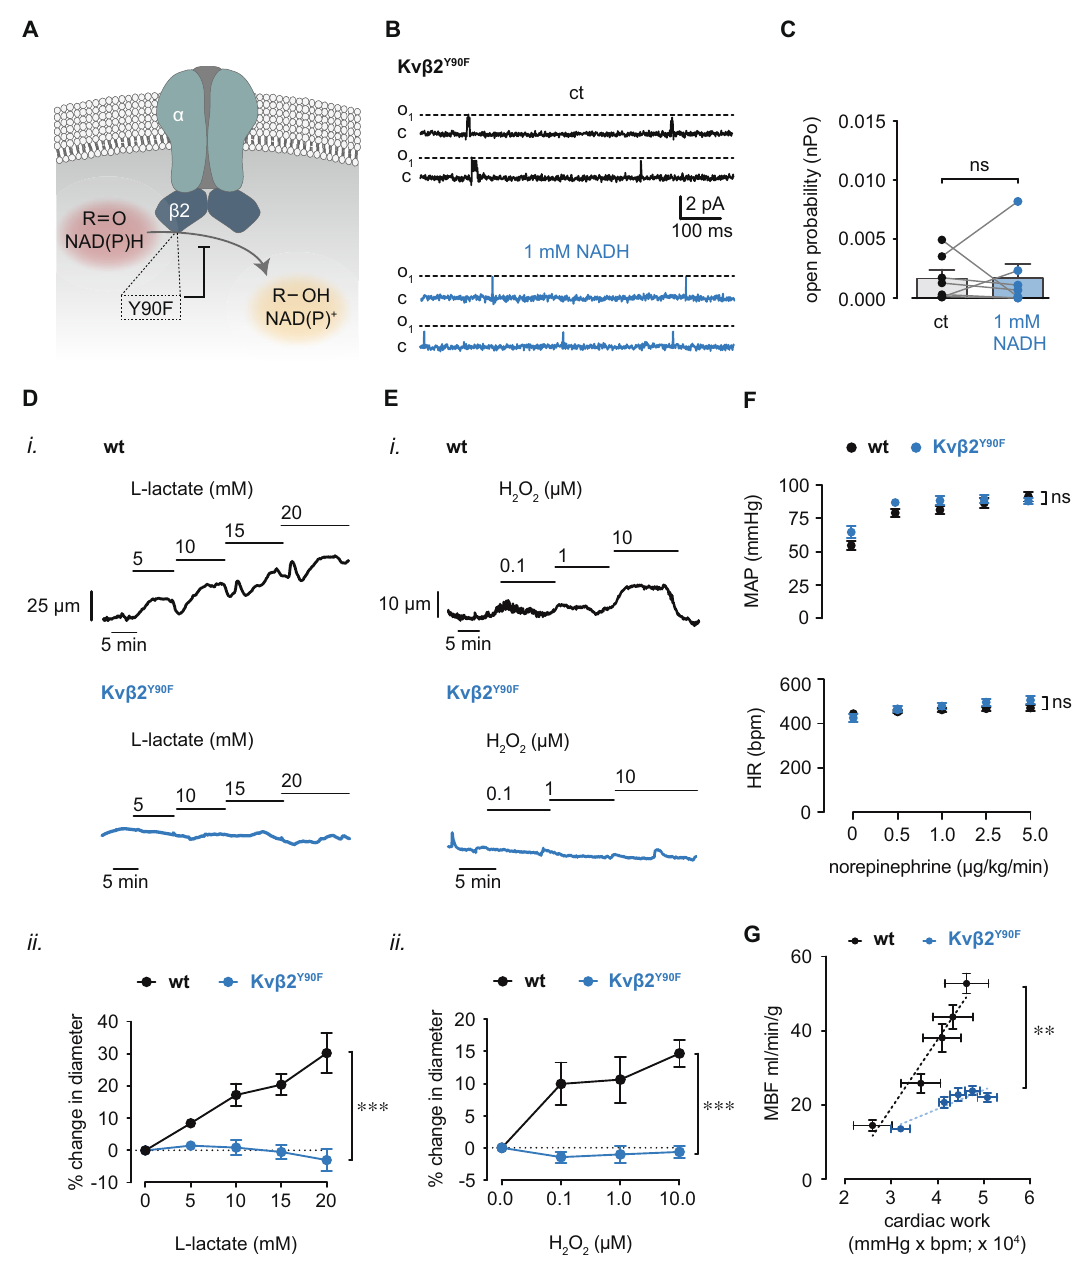
Fig. 5 Loss of Kv β 2 catalytic function prevents redox-mediated increases in Kv1 activity and vasodilation, and suppresses MBF. A Schematic illustration depicting abolished NADPH-dependent carbonyl reduction by Kv β 2 resulting from the Y90F point mutation. B Single-channel recordings showing Kv1 activity in membrane patches from Kv β 2 Y90F mice before and after application of 1 mM NADH. C Summary of Kv1 open probabilities (nPo; mean values ± SEM) in membrane patches from Kv β 2 Y90F mice before and after application of 1 mM NADH. n = 7 cells from 3 mice; ns: P ≥ 0.05 (two- sided Wilcoxon matched-pairs signed rank test). D Representative arterial diameter recordings in arteries from wild type (129SvEv) and Kv β 2 Y90F mice